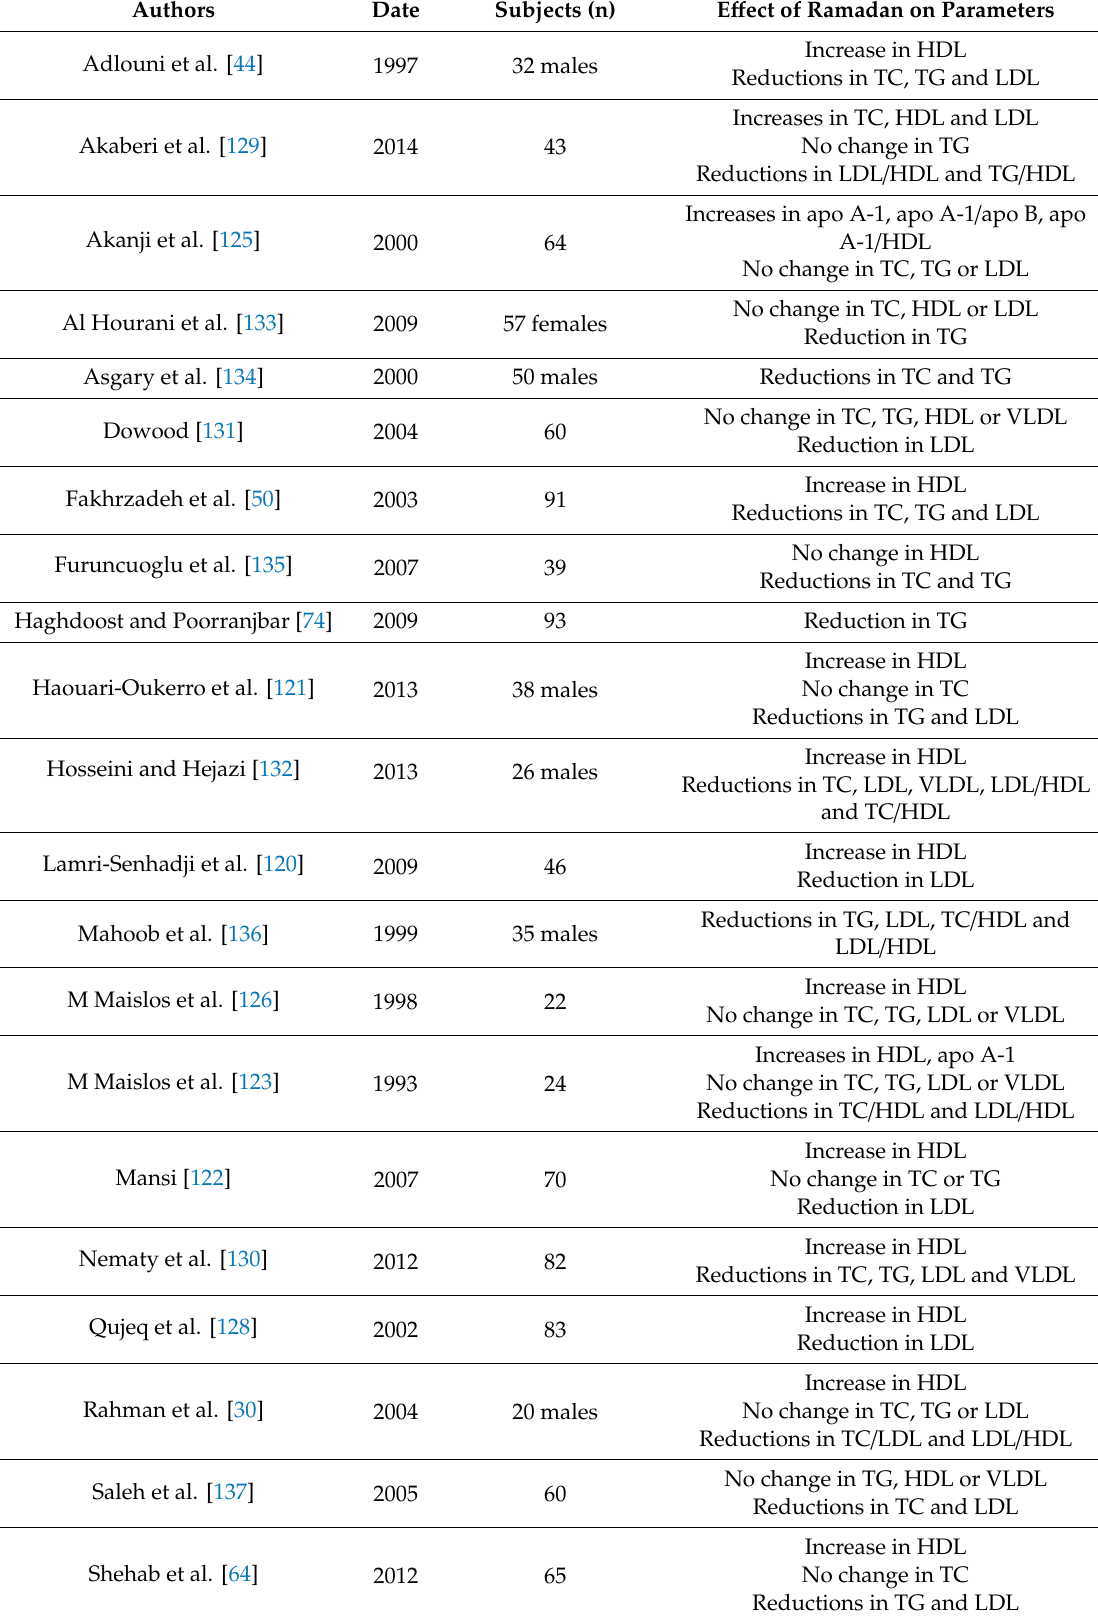
Table 7. E ff ect of Ramadan fasting on lipid profile in healthy